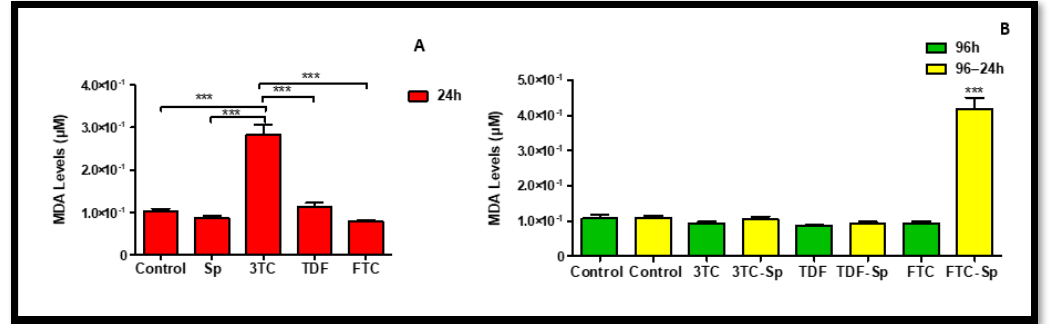
acute exposure to SP The MDA levels were significantly decreased in SP-treated cells and significantly increased for 3TC and TDF after acute exposure A: ( p < 0.0001), while de- creased in HAART – SP-treated HepG2 cells compared to the untreated cells B: ( p < 0.0001), except for FTC-SP, which showed a significant increase (Figure 10). except for FTC-SP, which showed a significant increase (Figure 10).